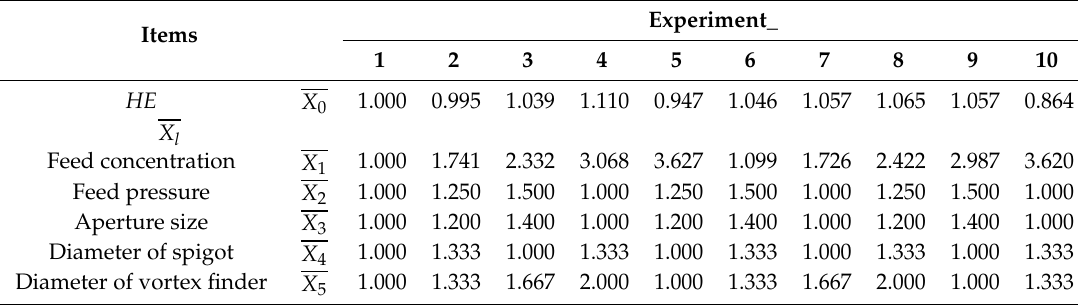
Table A1. Dimensionless of Grey System theory for